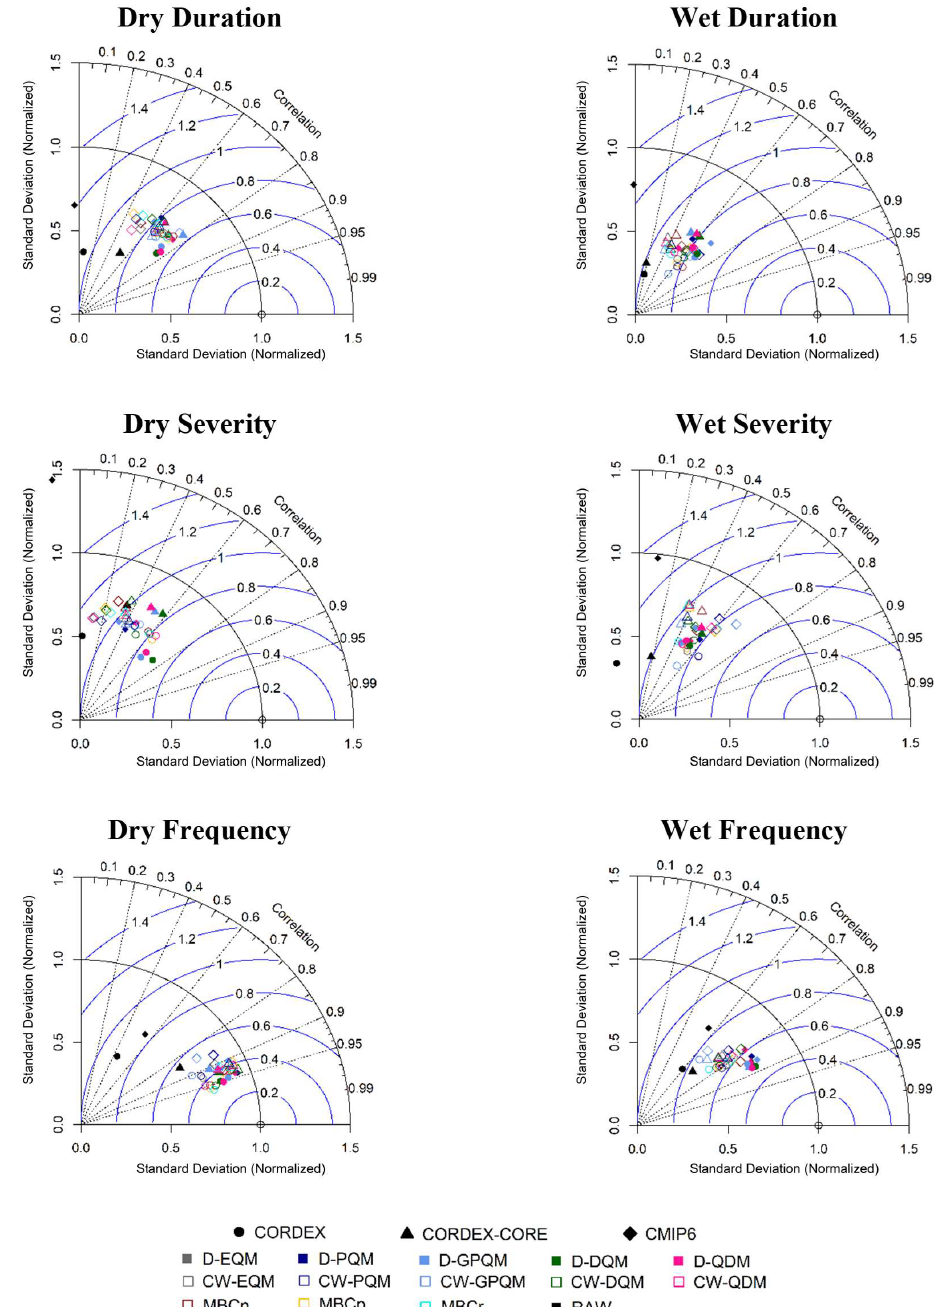
Figure 6. Taylor diagrams showing the performance of BC methods (colors) and datasets (markers) with respect to the spatial variability in the SPEI indices in the historical period (1986–2005) for the UJB. Each marker represents the evaluation measures for the multi-model ensemble mean SPEI indices for the three modeling experiments (CORDEX in circles, CORDEX-CORE in triangles, CMIP6 in diamonds). Filled markers: direct BC approach; non-filled markers: component-wise BC approach; black marker: raw model output. Note: in the case of CMIP6, D-EQM (filled grey diamond) and D-PQM (filled dark blue diamond) are grouped together for all SPEI indices. Note: in the case of CMIP6, D-QDM (filled pink diamond) and D-DQM (filled dark green diamond) are grouped together for all SPEI indices. Note: in the case of CORDEX and CORDEX-CORE experiments, D-EQM (filled grey marker), D-PQM (filled dark-blue marker), and D-QDM (filled pink marker) are grouped together for all SPEI